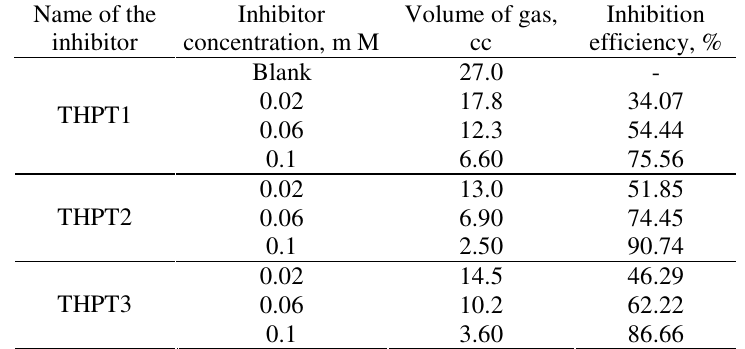
Table 7. Inhibition efficiencies for the selected concentrations of the inhibitors for